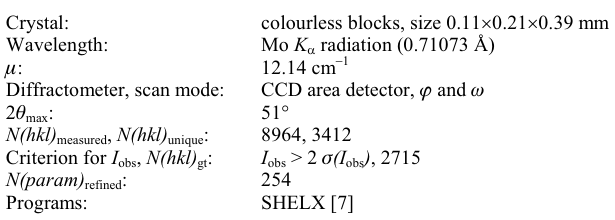
Table 1. Data collection and handling.